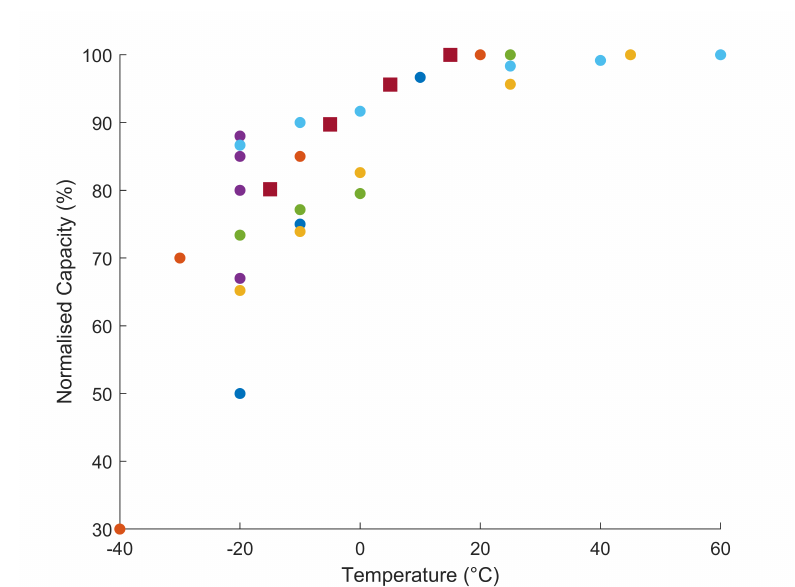
Figure 11. Battery model capacity prediction compared to results extracted from the following sources: